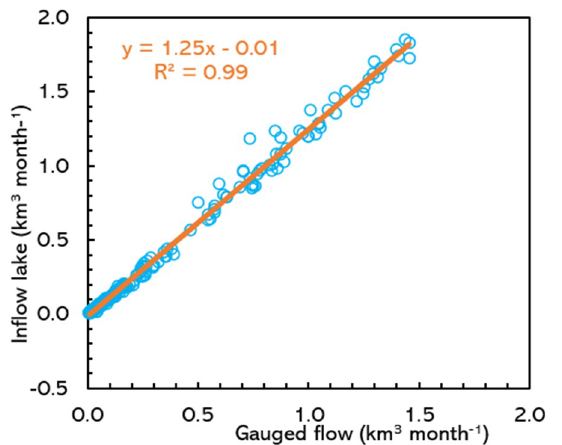
Figure 10. Regression of monthly gauged discharge vs. the simulated inflow of lake Tana for the four major rivers basins. The data (blue open circles) are taken from [44]. The best-fit line is orange.